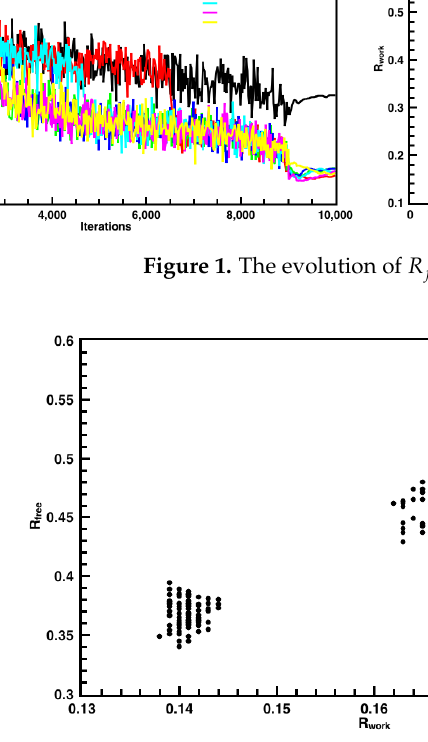
Figure 2. The distribution of the final R free and R work .